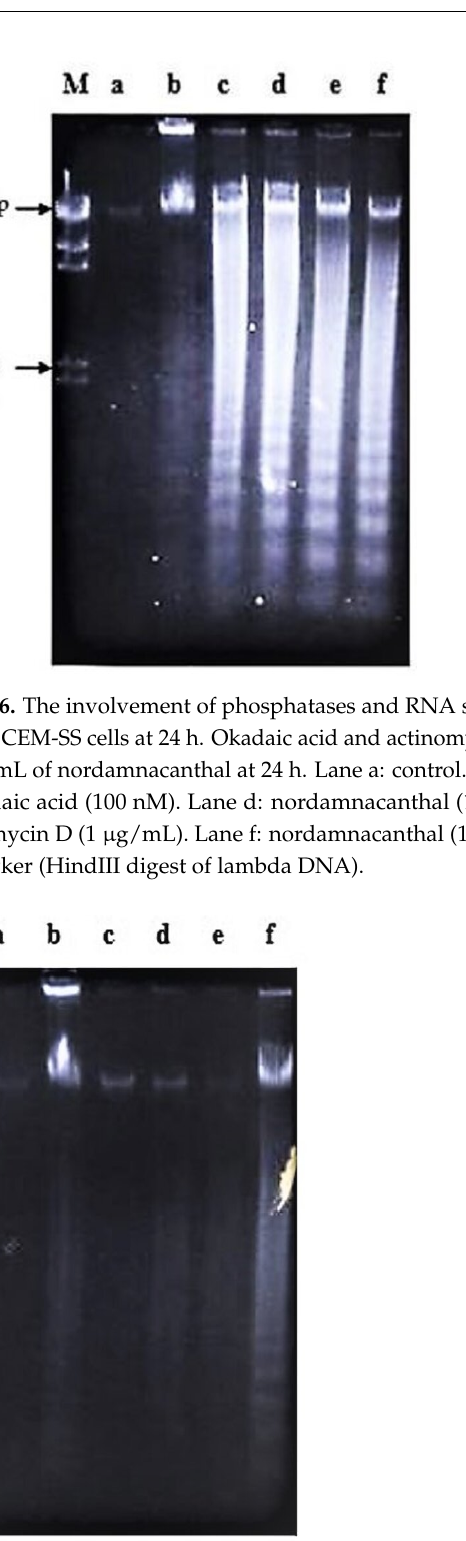
Figure 7. The involvement of an increase in cytosolic calcium concentration in nordamnacanthal- induced apoptosis in CEM-SS cells at 24 h. EGTA failed to prevent apoptosis induced by 10 μg/mL of nordamnacanthal at 24 h. Lane a: control. Lane b: nordamnacanthal (10 μg/mL). Lane c: EGTA (1 mM). Lane d: nordamnacanthal (10 μg/mL) + EGTA (1 mM). Lane e: EGTA (8 mM). Lane f: nordam- nacanthal (10 μg/mL) + EGTA (8 mM). Lane M: Marker (HindIII digest of lambda DNA).